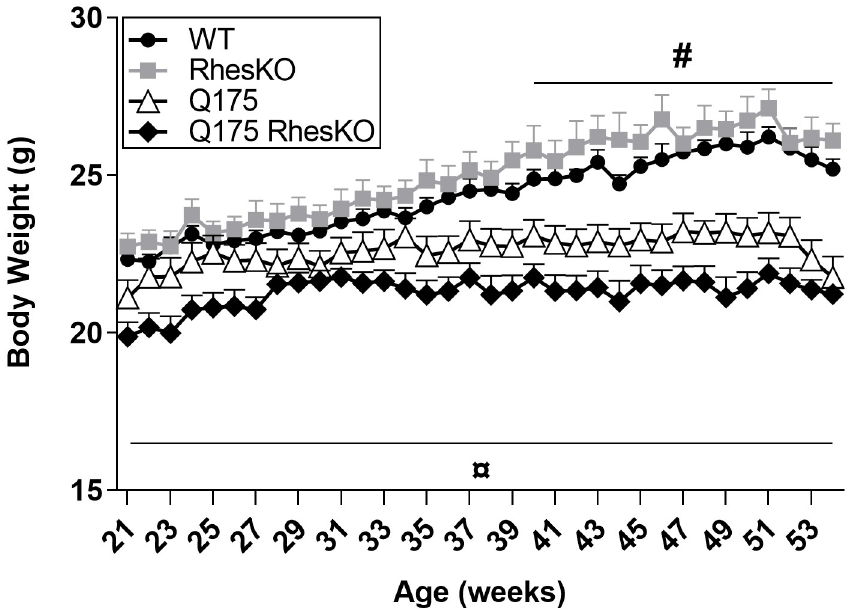
Fig 1. Body weight of Q175;RhesKO female mice from 21 to 54 weeks of age. Data are presented as mean ± SEM (WT n = 9; RhesKO n = 11; Q175 n = 9; Q175;RhesKO n = 9); Two-way mixed ANODE followed by Tukey’s test, # p < 0.05, Q175 vs. WT; ¤ p < 0.05, Q175;RhesKO vs. WT). There was no significant difference between Q175 and